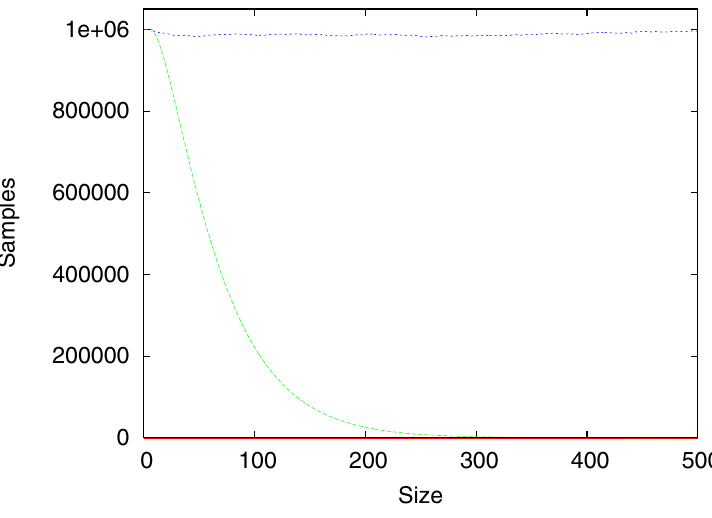
Fig. 4. Attrition of started walks with PERM compared with Rosenbluth Sampling. In the case of PERM, a virtually constant number of samples is obtained.